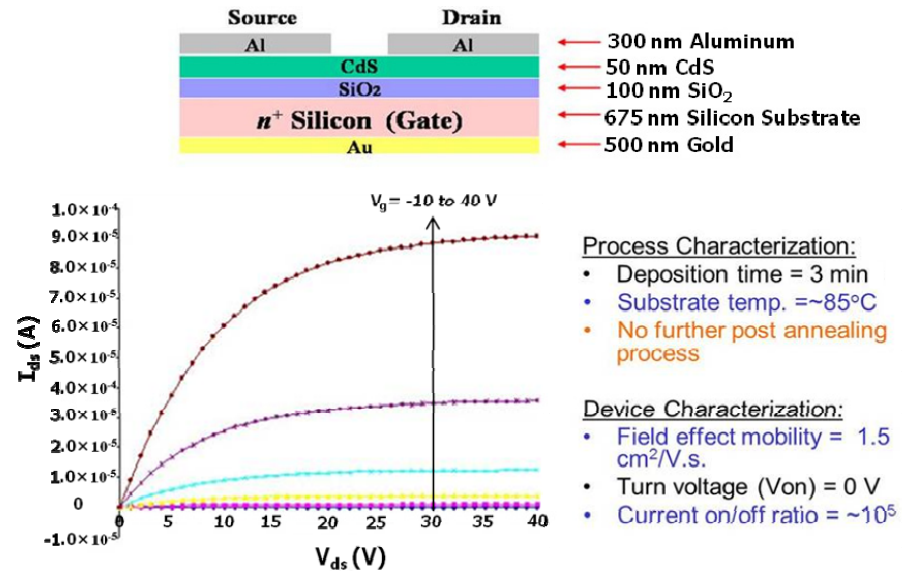
Figure 5. Structure, device performance and output characteristic curves of CdS metal insulator semiconductor field-effect transistors (MISFETs). Reproduced from